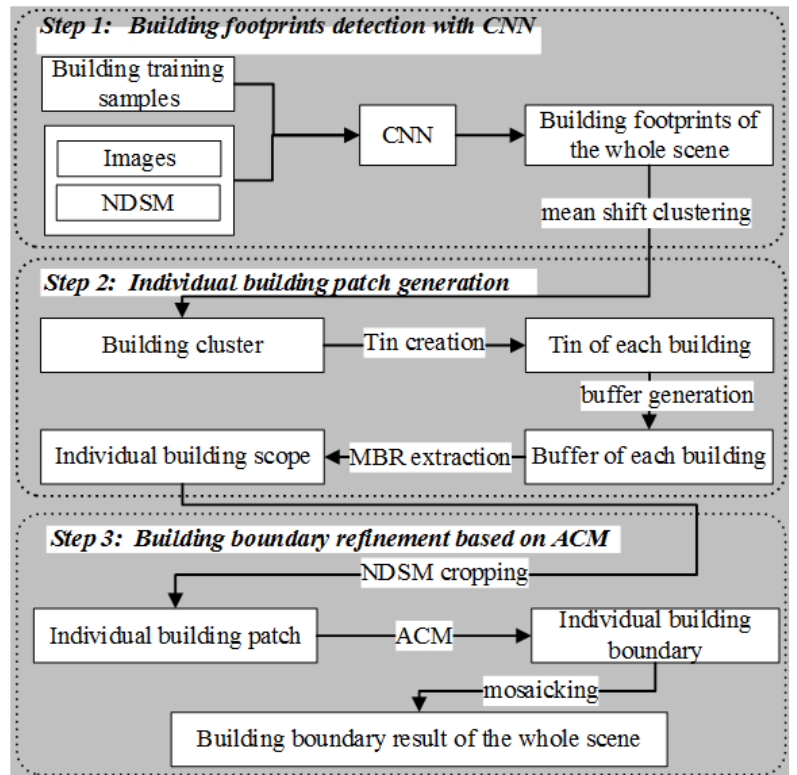
Figure 4. The flowchart of the CNN_ACM_2 building boundary extraction